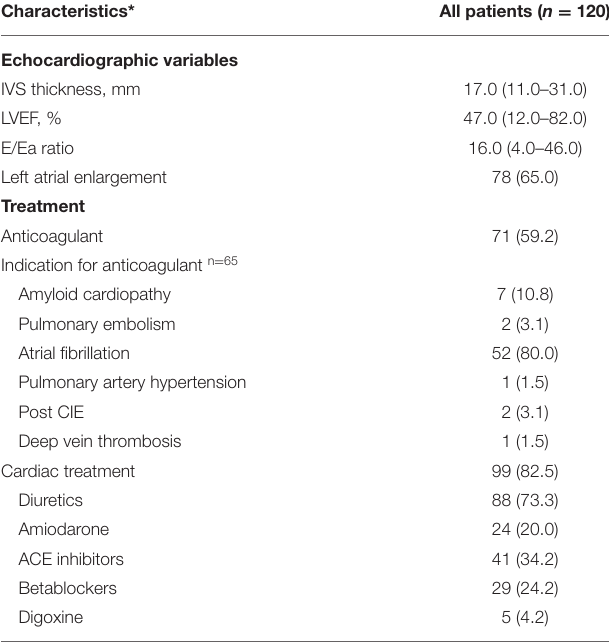
CIE over a median CATTR follow-up of 2.0 years